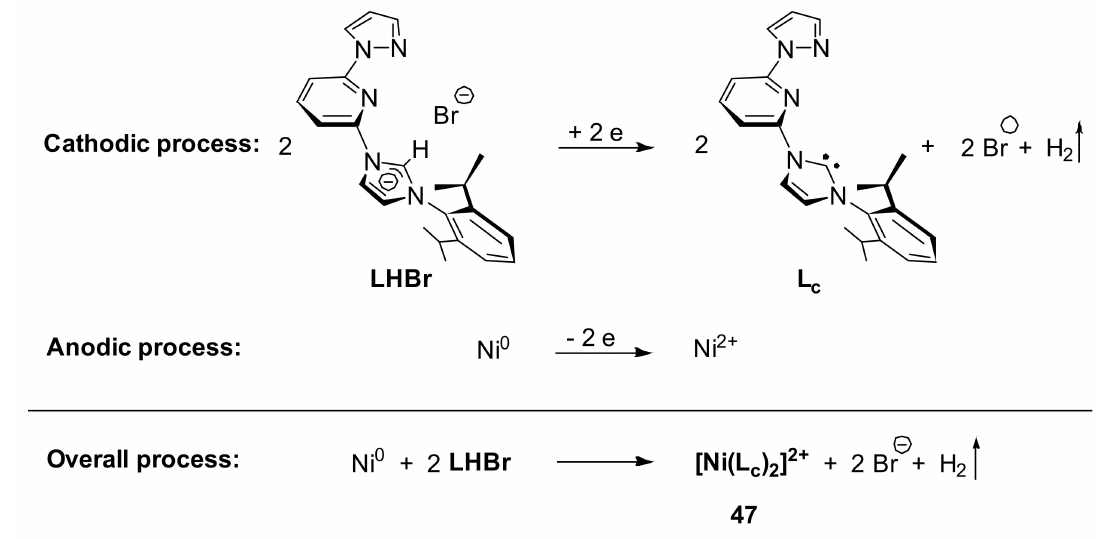
Vabre et al. demonstrated the synthesis of nickel complexes with PIMCOP, PIMIO- COP and NHCCOP ligands (Scheme 27) [143]. PIMCOP complex 48 was obtained by nickelation of an unsymmetrical meta-phenylene-based ligand bearing phosphinite and imidazolophosphine groups. N -methylation of the latter generates a new PIMIOCOP com- plex 49 with NHC moiety, which can be converted subsequently into NHCCOP complex 50 (Scheme 27). Interestingly, the Ni-P distance in 50 is much longer (2.145 Å) compared to the related Ni-P bond of 48 and 49 (2.132 and 2.133 Å). These indicate the much stronger trans influence of the NHC moiety compared to the phosphine